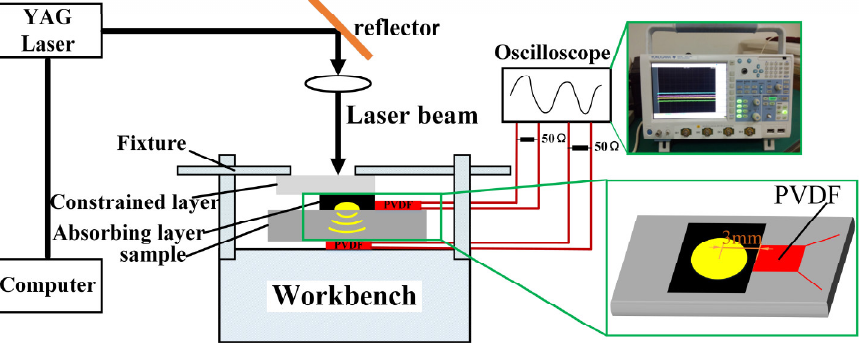
Figure 3. Schematic diagram of detection of dynamic strain induced by laser shock on a sample. An X-ray stress analyzer (LXRD type, Proto, Ottawa, Canada) was used to measure the residual stress distribution on the surface of the impact area. The five measurement points are located along the same diameter of the laser shock spot, as illustrated in Figure 4. Each measurement point was measured once in each of the three directions of 0°, 45°, and 90°. The test parameters were selected as follows: collimating tube diameter: 1 mm; target material: Cr target; Bragg angle: 156°; crystal face type: (211); tube voltage: 30 kV; tube current: 25 mA; and exposure time: 15 s.